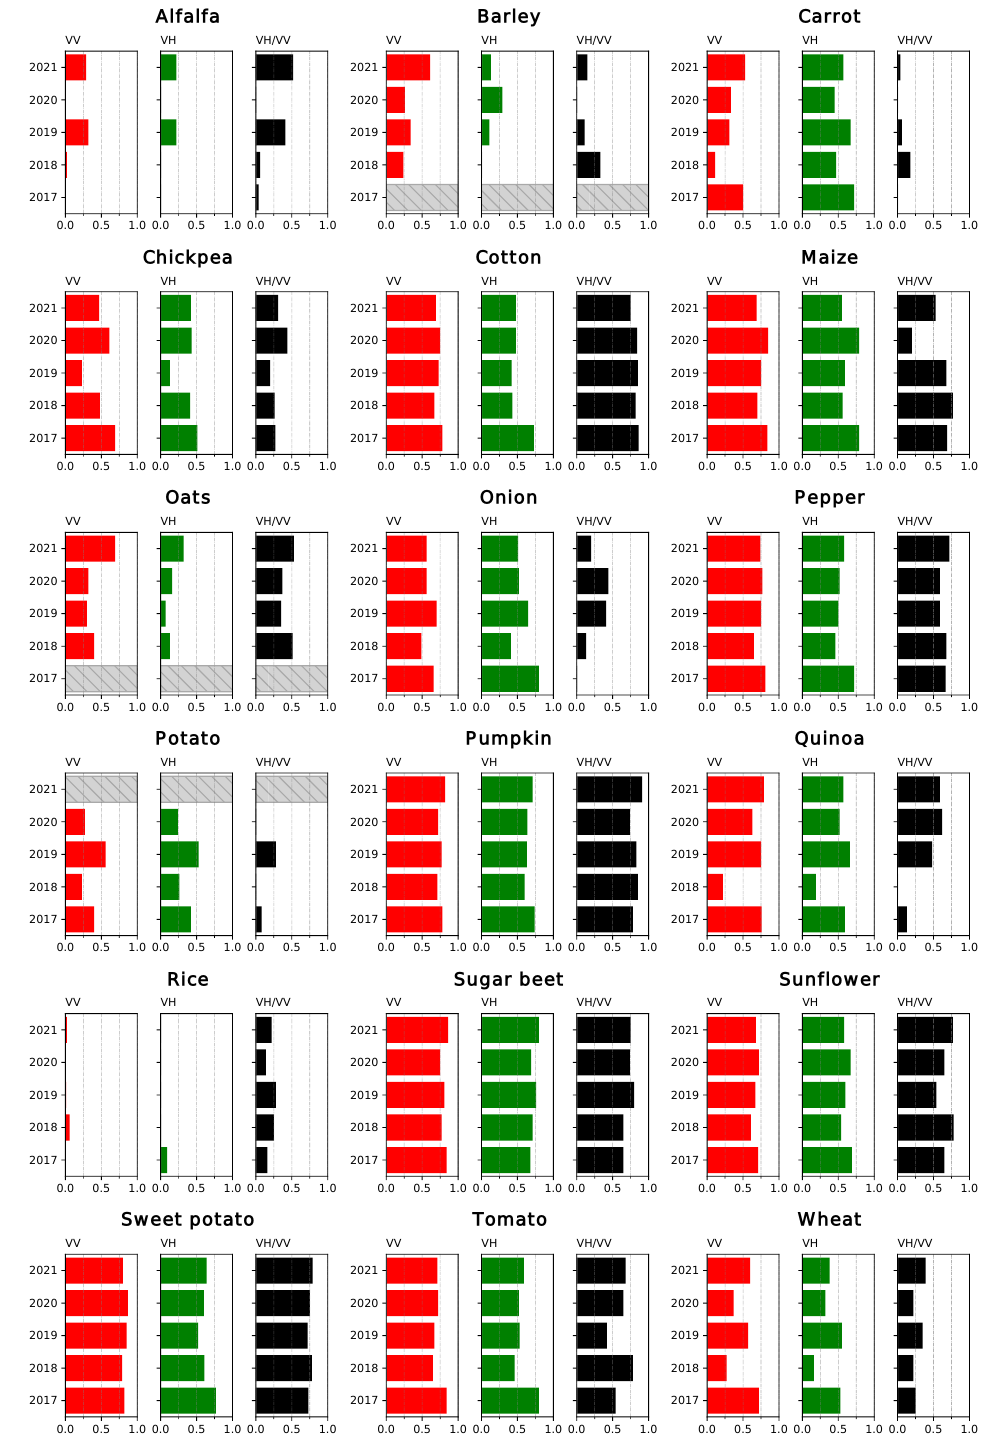
Figure 6. Coefficient of determination ( R 2 ) for the linear regressions between coherence and NDVI, considering the complete time series. Years without data for a specific crop type are identified with a striped